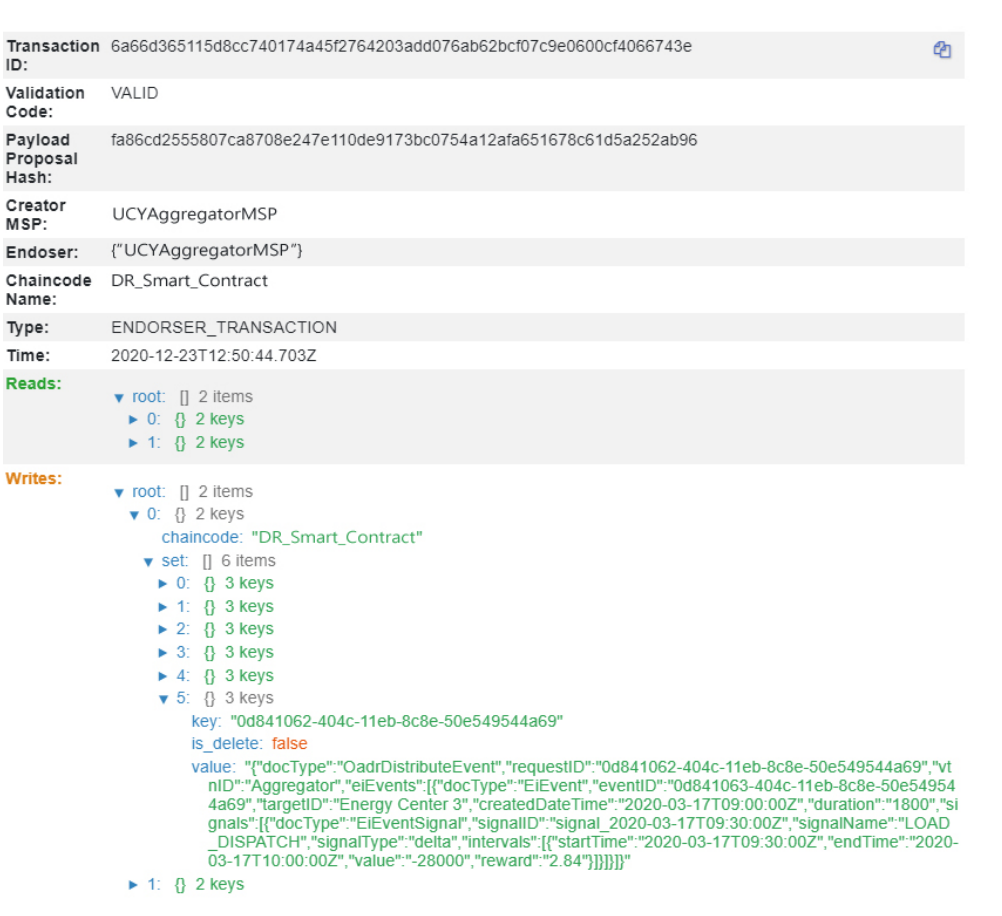
Figure 4. Issuance transaction of a DR event originating from the aggregator and in which Energy Center 3 is specified as the